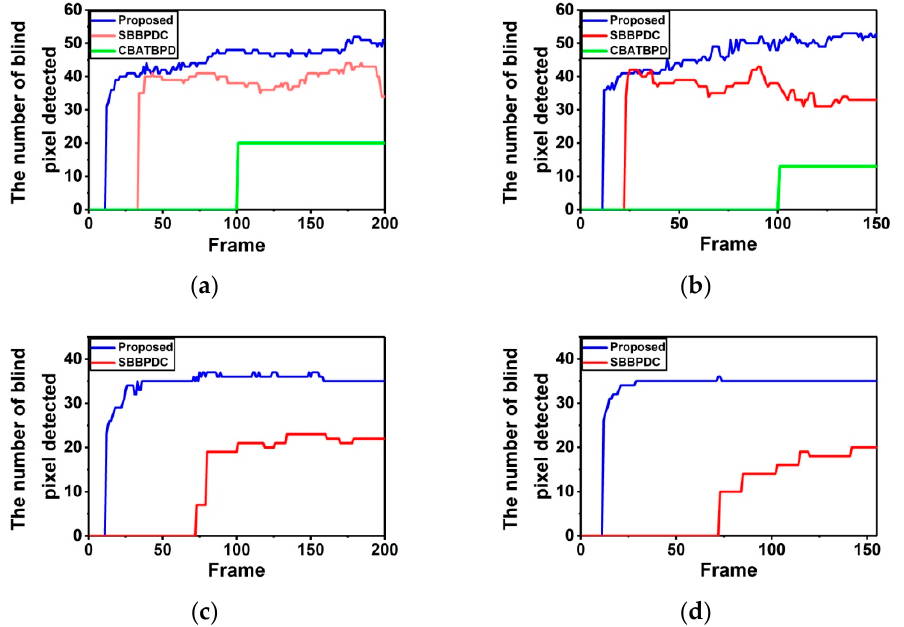
Figure 8. The number of blind pixels detected by different methods in each frame ( a ) sky background; ( b ) sky background with IRPT; ( c ) deep space background; ( d ) deep space background with IRPT.